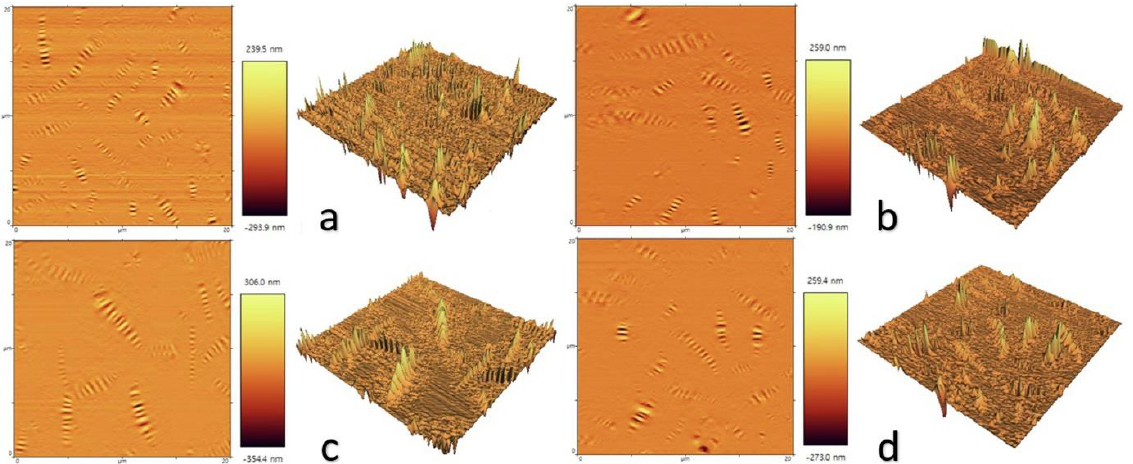
Figure 10. The topographic images of the unmodified and modified binders. ( a ) Control; ( b ) Soap; ( c ) Post; ( d ) Co-mill. Reprinted with permission from [108]. © 2022 Elsevier Ltd.